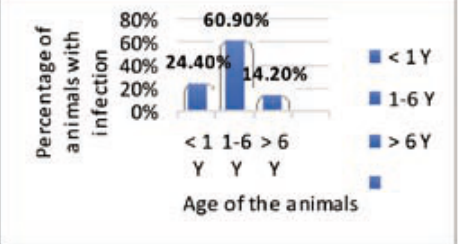
Fig. 6. Age wise distribution of malassezia infection